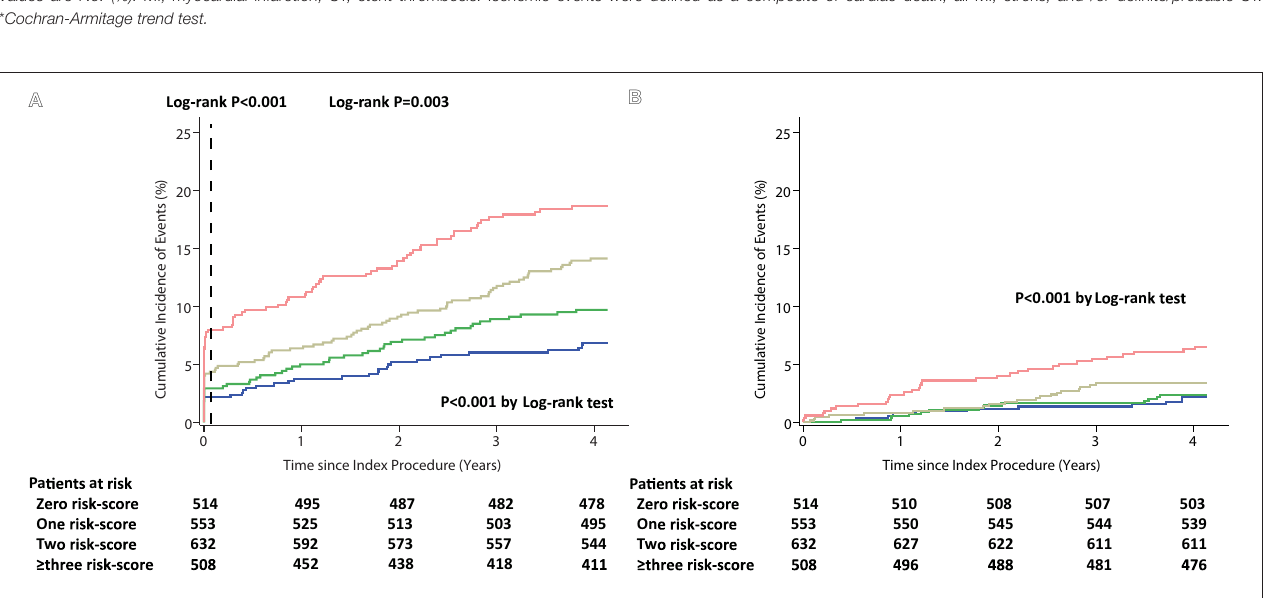
is shown in Supplementary Table S2 . The lesion characteristics and procedural results are shown in Table 2 stratified across cumulative risk-score